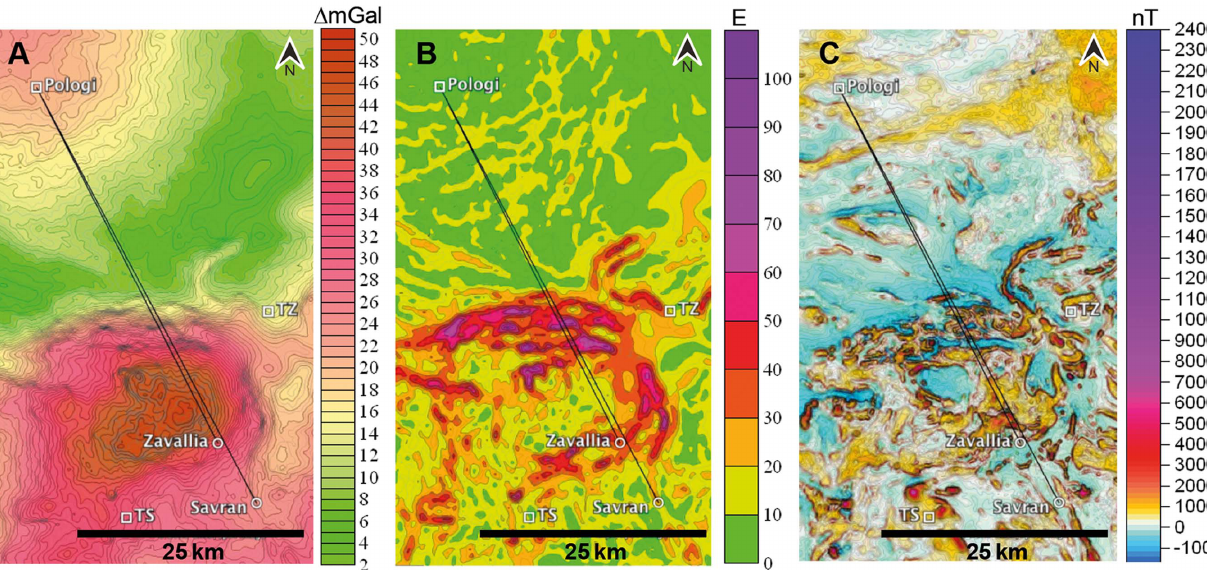
Figure 2. Gravity and magnetic anomalies of the test region crossed by the pigeons. (A) Gravimetric anomalies, the change of the gravity intensity ( D G B – Bouguer, mGal=milligal); (B) Horizontal gravity gradients (E=Eo¨tvo¨s), highest values mark locations with steepest gradient of gravimetric values in border zones of gravimetric anomalies. (C) Magnetic anomaly map (nT). The square symbols indicate the release sites: Pologi, the experimental release site; TZ, the last training flight to Zavallia loft; and TS, the last training flight to Savran loft. Black lines indicate beelines from the experimental release site to the Z- loft (46 km) and the S-loft (54 km).